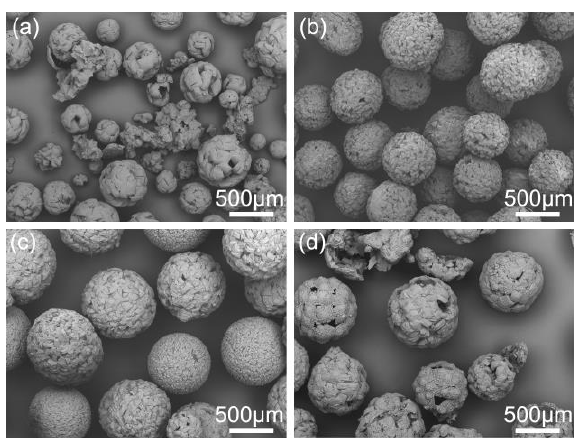
Figure 11. SEM images of spherical crystals prepared at different aqueous temperatures: ( a ) 5 °C, QESD-1; ( b ) 20 °C, QESD-2; ( c ) 30 °C, QESD-3; ( d ) 40 °C, QESD-4.